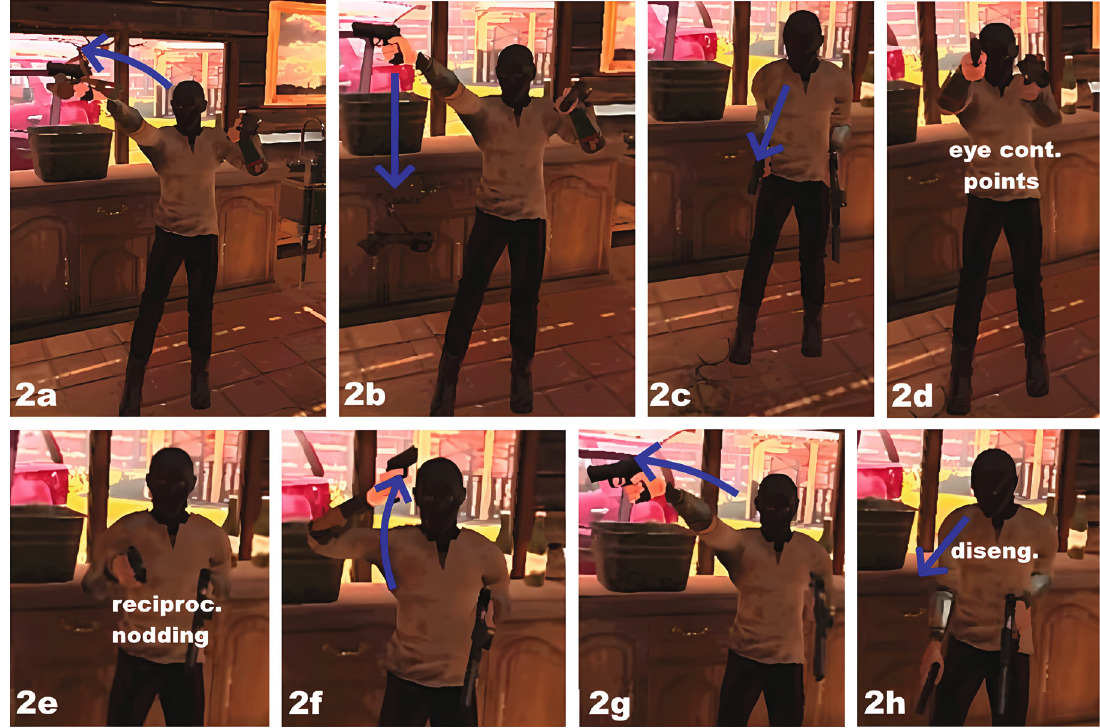
Figure 12: Disambiguational work through sequential modi fi